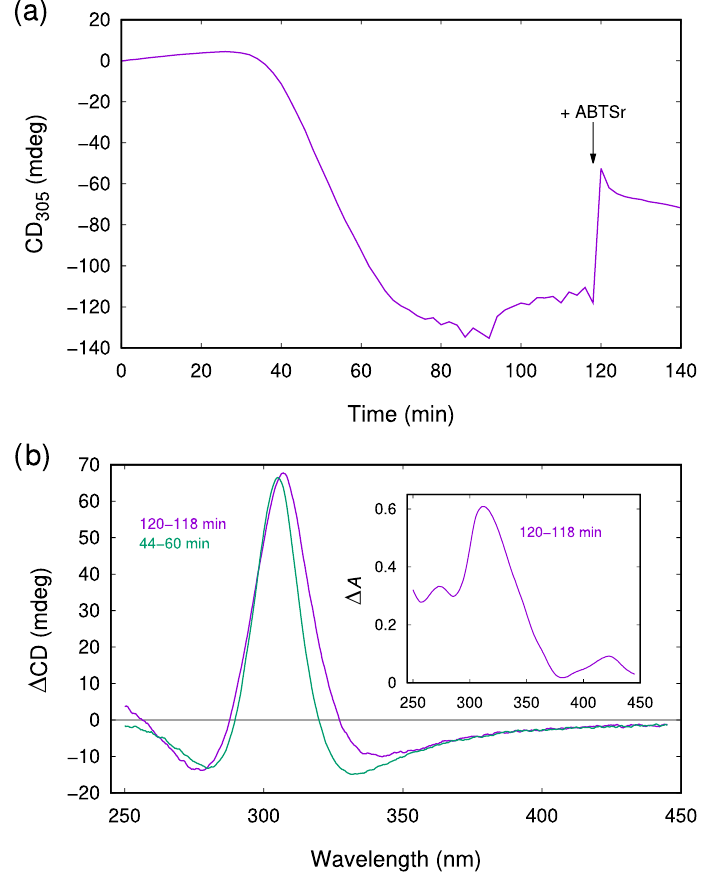
Figure 9. CD and UV/Vis spectrophotometric analysis of the effect of ABTSr addition (at 118 min) during the reaction of 300 µ M Cu 2+ with 300 µ M NAC in 40 mM HClO 4 at 20 ◦ C. The spectra (445 → 250 nm, resolution 0.2 nm) are scanned in 2 min cycles at a rate of 100 nm min − 1 . ( a ) A time record of the ellipticity at 305 nm; 20 µ M of ABTSr is added at 118 min (arrow) from the beginning of the reaction. The ABTSr addition causes a decrease (in absolute value) in the CD 305 signal of about 55%. ( b ) Difference CD and UV/Vis (inset) absorption spectra plotted as difference ellipticity ( ∆ CD) and difference absorbance ( ∆ A ) vs. wavelength. Details are explained in the